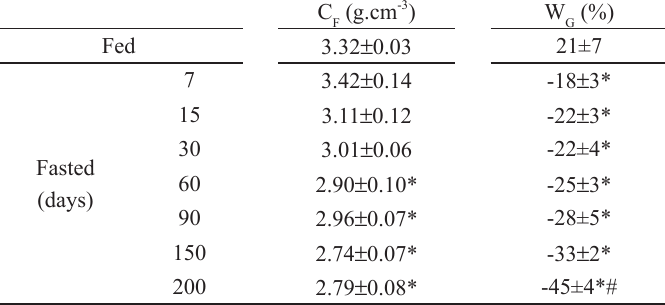
Body parameters of fed and fasted red tilapias ( Oreochromis